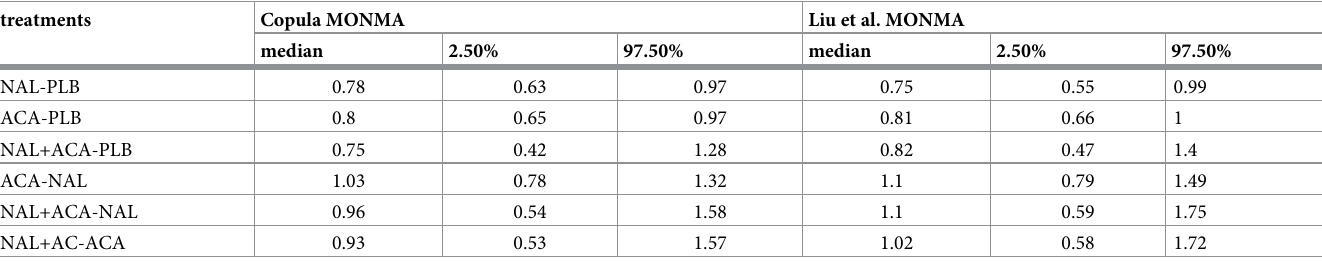
Table 7. Discontinuation: Pooled effects posterior median and HPD 95% credibility intervals. treatments Copula MONMA